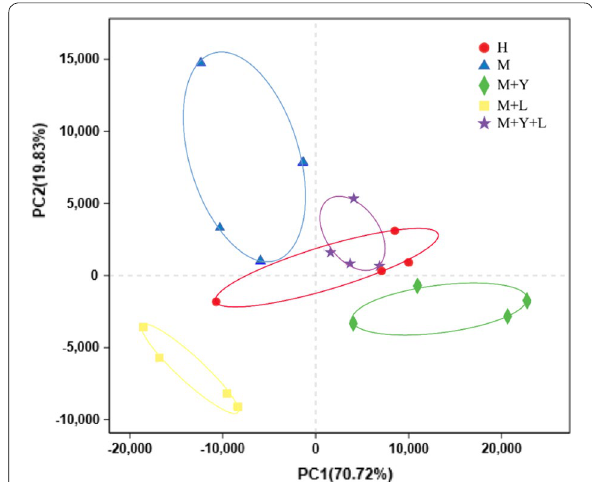
Fig. 2 PCA analysis of milk samples microbiota of different